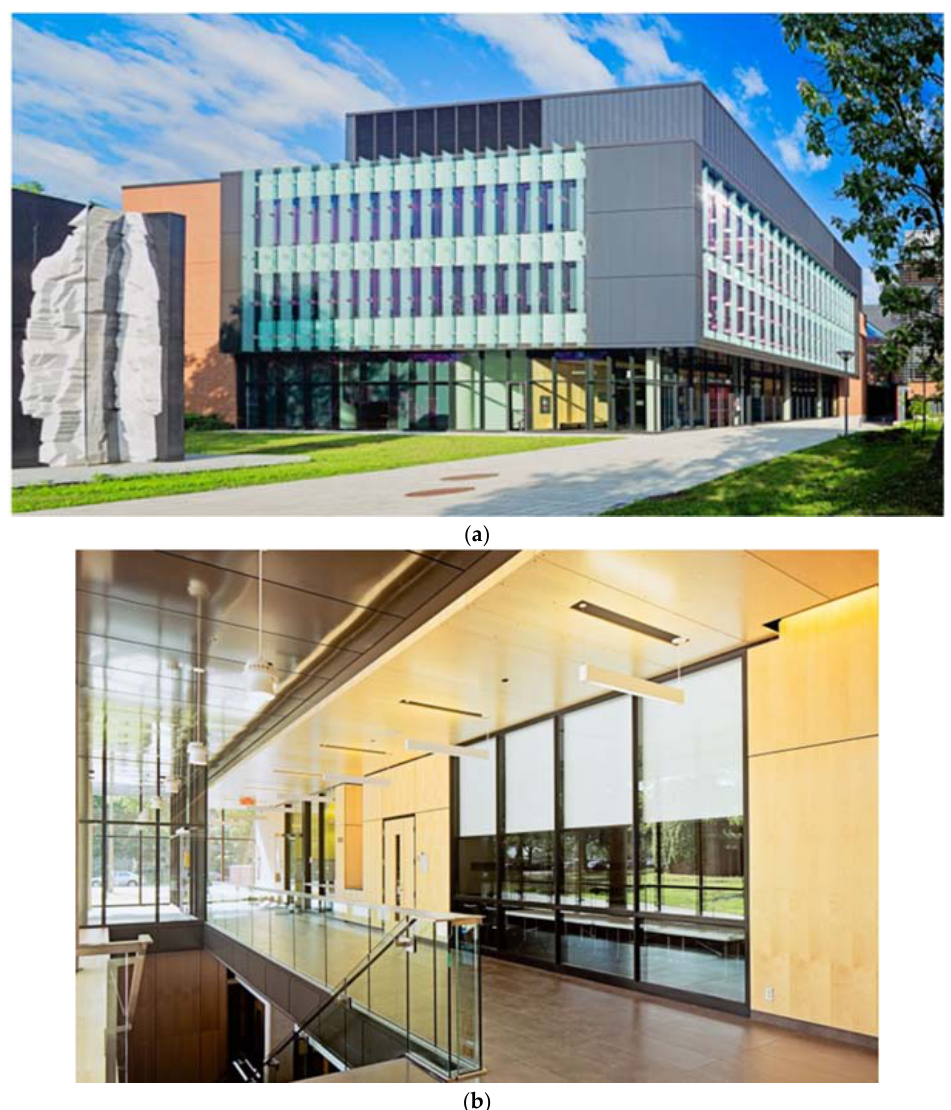
Figure 1. View of Genomic building: ( a ) outside view, and ( b ) inside view of ground floor level. Measurements used in this paper were recorded by 10 physical sensors (Table 2) at 15-min interval, over the heating season from 26 December 2016 to 29 January 2017. For comparison with measurements, four sensors were modelled: T ma and T ahc by using SVR models, and T oa and T ra by using RNN models.